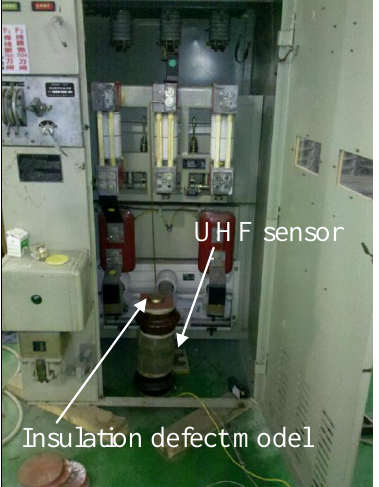
Figure 8. Testing switchgear.